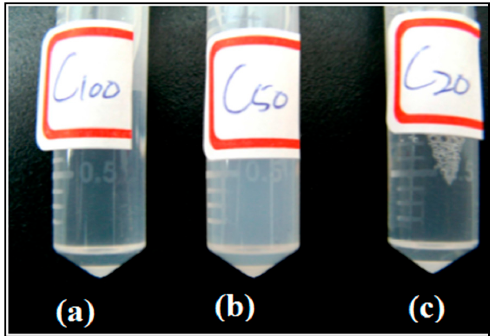
Figure 3. The results of hydration of the micelle aqueous solutions. ( a ) MC 100 ; ( b ) MC 50 ; ( c ) MC 20 .